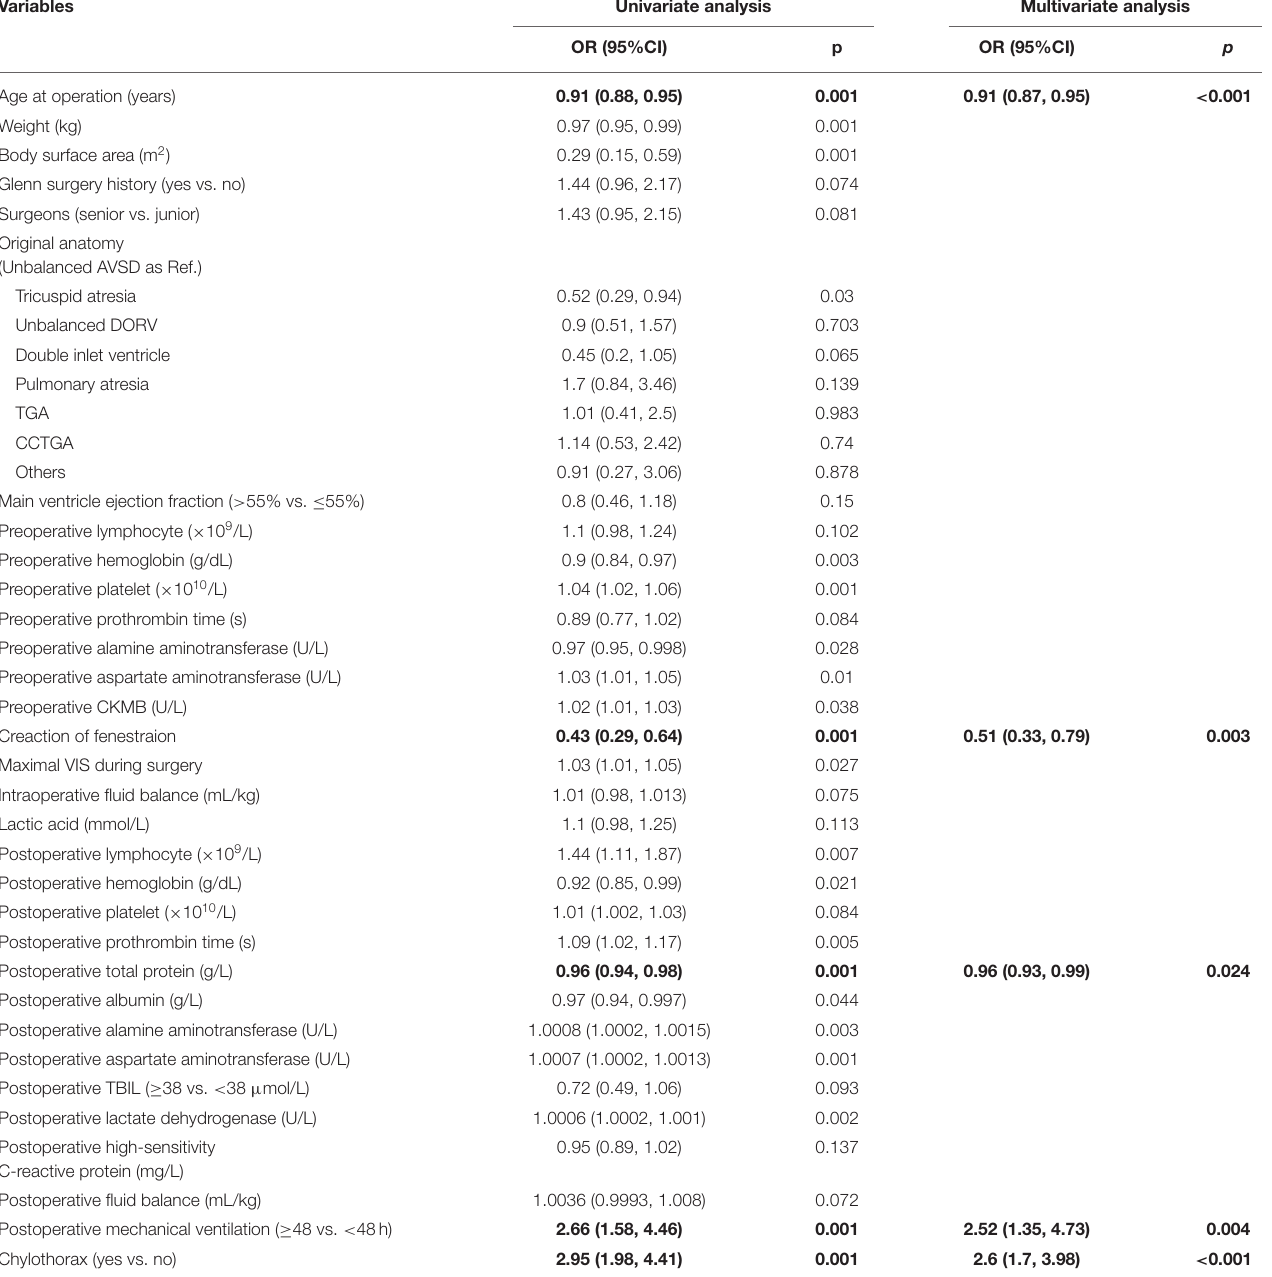
TABLE 4 | Univariate and multivariate logistic analysis odds ratios for prolonged pleural effusion. Variables Univariate analysis Multivariate